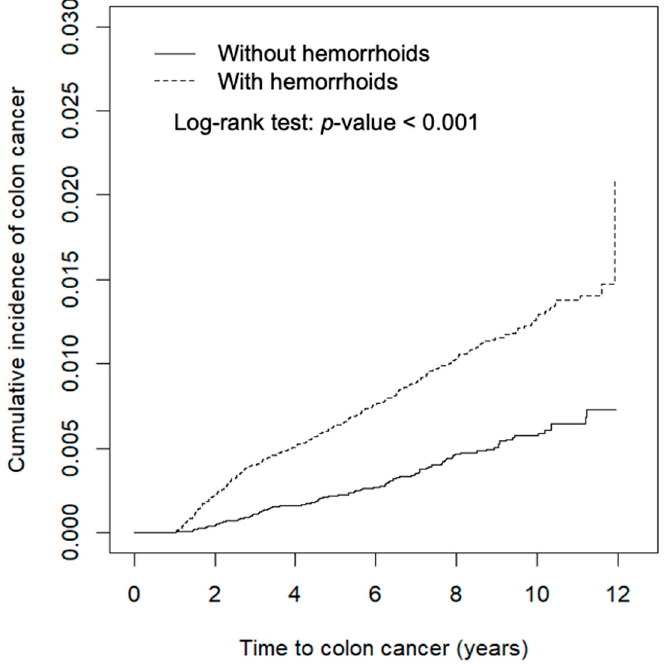
Figure 1. Cumulative incidence of colorectal cancer of cohorts with and without hemorrhoids, as obtained using the Kaplan–Meier method.